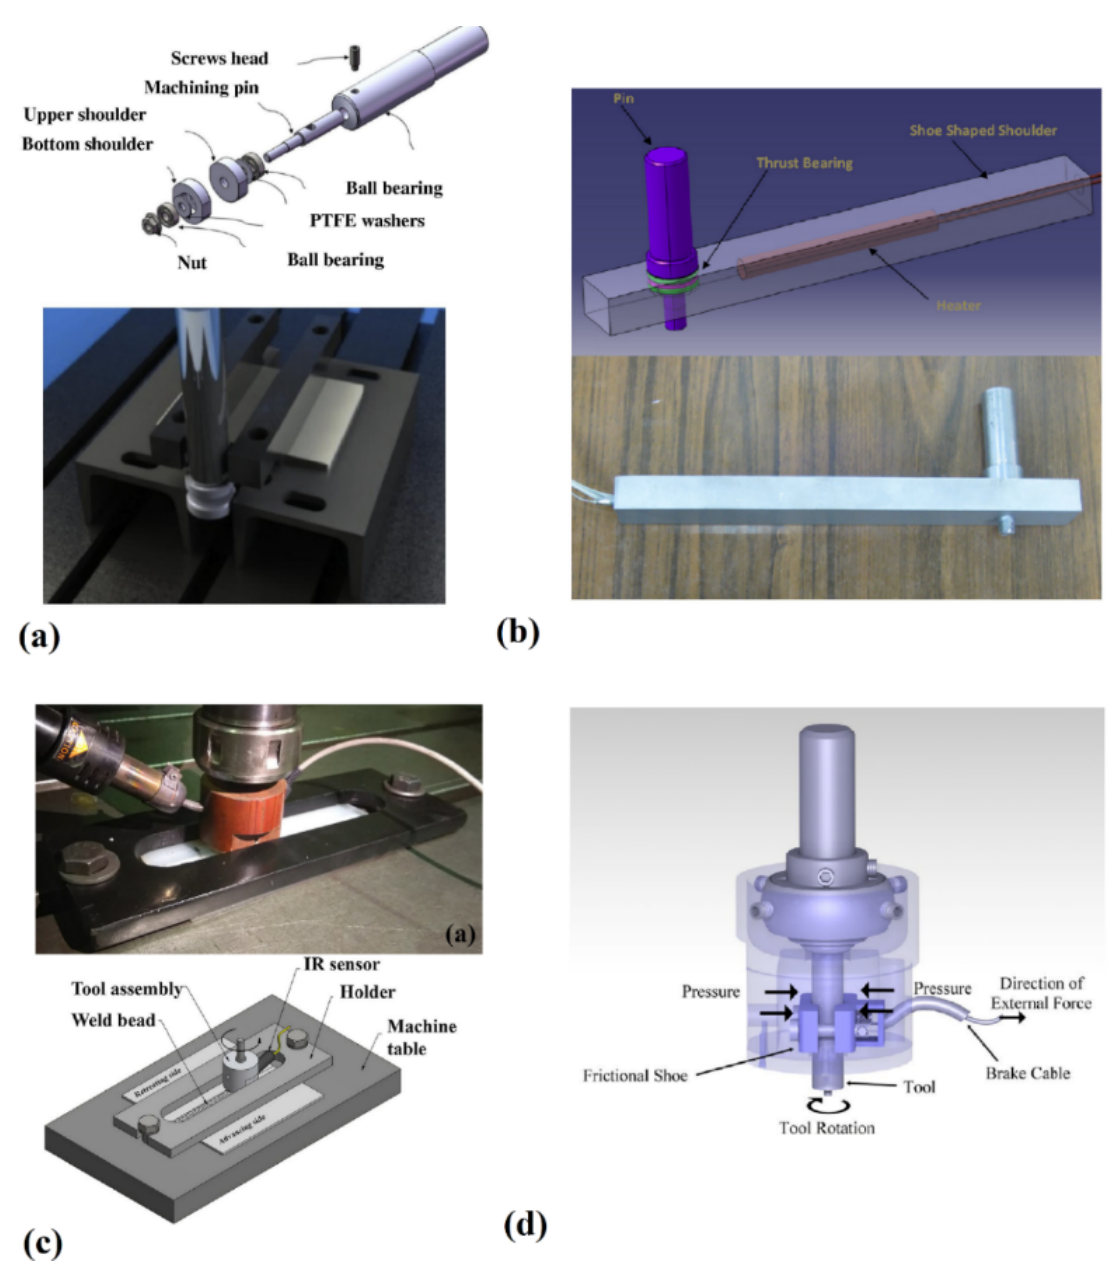
Figure 21. LFSW new designed tool used by ( a ) Pirizadeh et al. [66], ( b ) Azarsa and Mostafapour [67], ( c ) Moochani et al. [69], ( d ) Nath et al. [70].